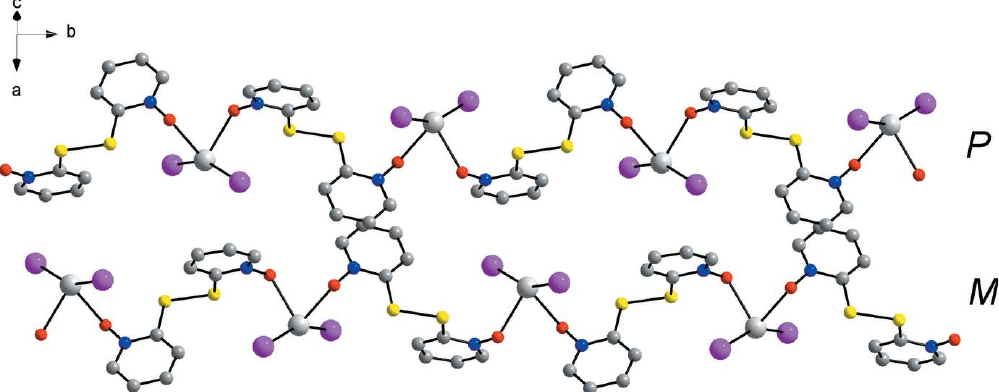
Figure 2 Two adjacent coordination polymer strands of the title compound, viewed along the [101] direction. P and M denote the handedness of the 2,2 0 -